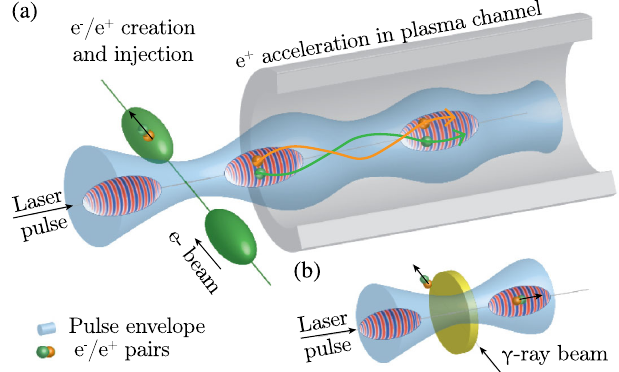
FIG. 1. (a) Setup: electron-positron pairs (in green/orange) are created during the interaction of an intense laser pulse (blue/red) with a relativistic electron beam (green) at a 90° incidence angle. A fraction of the pairs is injected and propagates with the pulse through the plasma channel, experiencing direct laser acceler- ation. (b) Quasi-3D modeling of this setup. A slab of γ -ray photons from the electron-laser collision is initialized at t ¼ 0 .